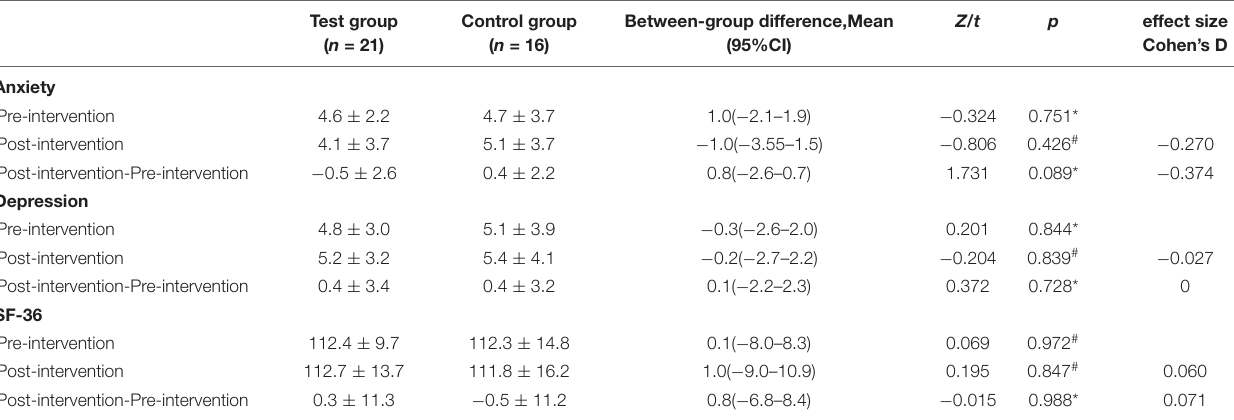
TABLE 3 | Changes in secondary